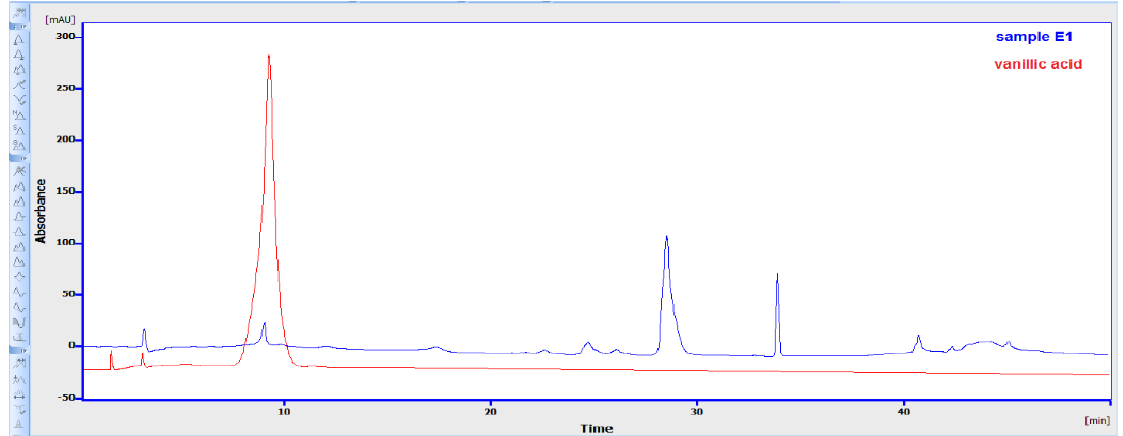
Figure 4. HPLC chromatogram of standard vanillic acid and isolated cpd